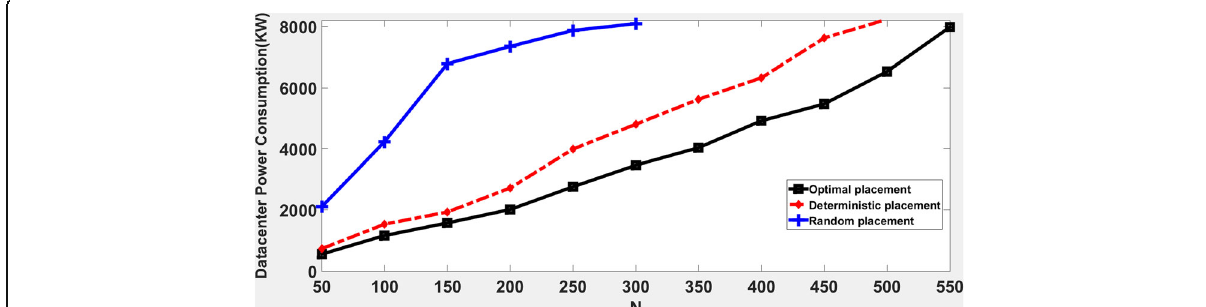
Fig. 5 Optimal, deterministic and random heuristic power consumptions as a function of the number of jobs in the system for constant server power